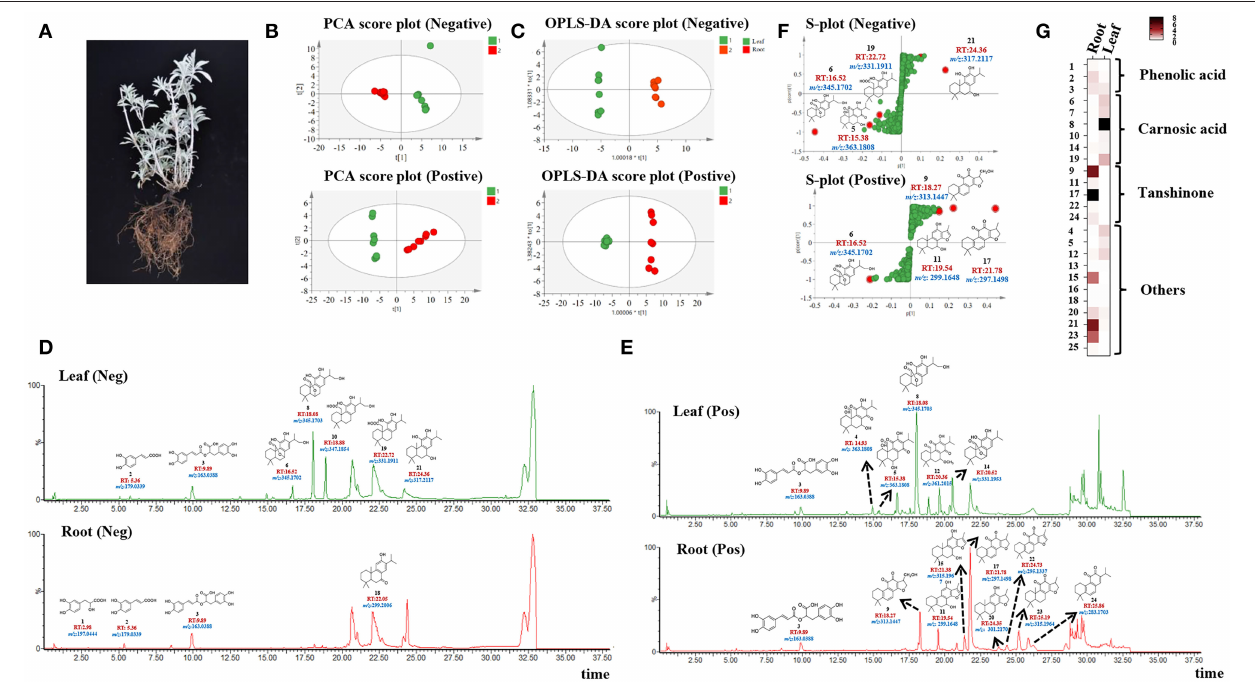
FIGURE 1 | Metabolomics and chemometric analyses of extracts from roots and leaves by QTOF-MS in Salvia apiana . (A) Image of whole plant of S. apiana . (B) PCA analysis of roots and leaves in the negative-ion and positive-ion modes. (C) OPLS-DA analysis of roots and leaves in the negative-ion and positive-ion modes. (D) Total ion current (TIC) chromatograms of leaves and roots in the negative-ion modes annotated with identified metabolites (1, 2, 3, 6, 8, 10, 18, 19 and 21), including corresponding structure, retention time (RT), and mass to charge ratio (m/z). (E) Total ion current (TIC) chromatograms of leaves and roots in the positive-ion modes annotated with identified metabolites (3, 4, 5, 8, 9, 11, 12, 14, 15, 17, 20, 23 and 24), including corresponding structure, retention time (RT), and mass to charge ratio (m/z). (F) S-plot derived from OPLS-DA analysis in the negative-ion and positive-ion modes annotated with the most distinct metabolites, including corresponding structure, retention time (RT), and mass to charge ratio (m/z). (G) Relative content of identified metabolites in roots and leaves. 1, danshensu; 2, caffeic acid; 3, rosmarinic acid; 6, 16-oxhydryl-carnosol; 7, rosmanol; 8, 16-oxhydryl-isocarnosol; 9, 17-oxhydryl-cryptotanshinone; 10, 6-oxhydryl-carnosic acid; 13, 11, 20-dihydroxysugiol; 14, carnosol; 16, 11-hydroxysugiol; 17, cryptotanshinone; 18, sugiol; 19, carnosic acid; 22, tanshinone IIA; 24, miltirone; 25, 11-hydroxyferruginol. Names of metabolite 4, 5, 11, 12, 15, 20, 21 and 23 were listed in Supplementary Table 1